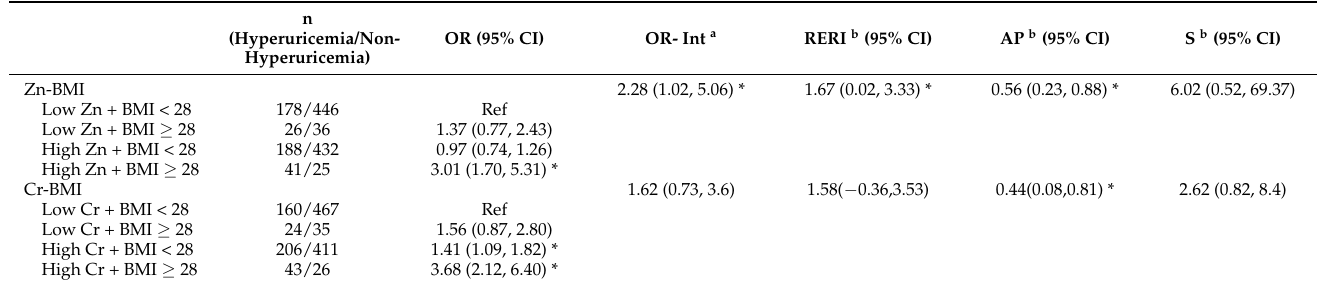
Table 5. Odds ratios and 95% confidence intervals for hyperuricemia according to the combined categories of whole blood metal concentrations and BMI in